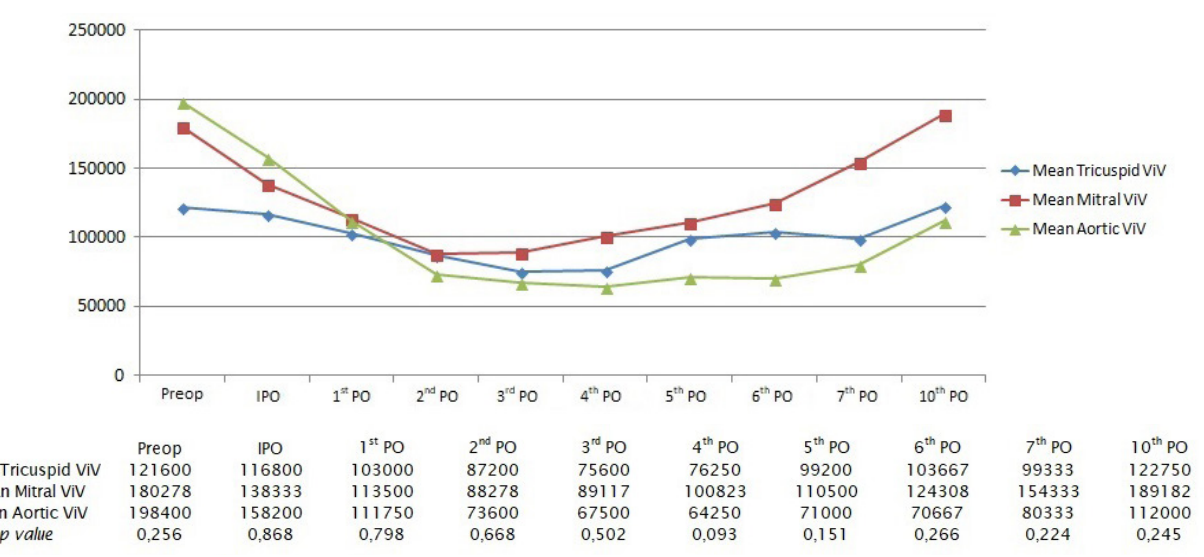
Fig. 1 - Mean platelet curves for all patients who underwent a valve-in-valve procedure.